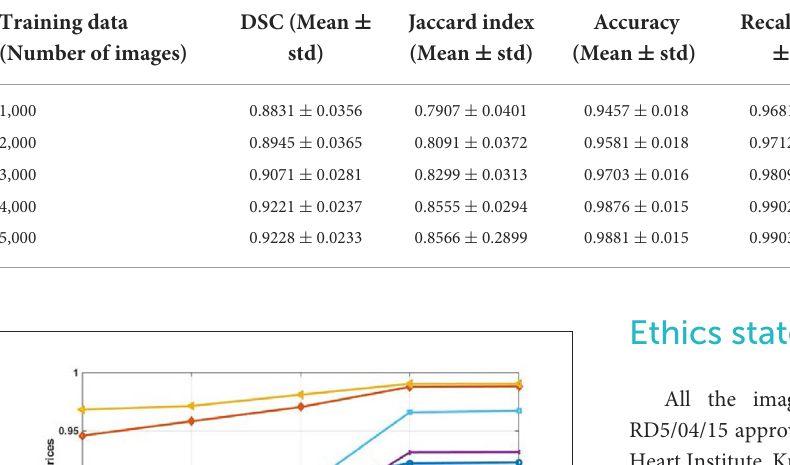
TABLE 2 Mean with standard deviation values of evaluation metrics using different training data size.